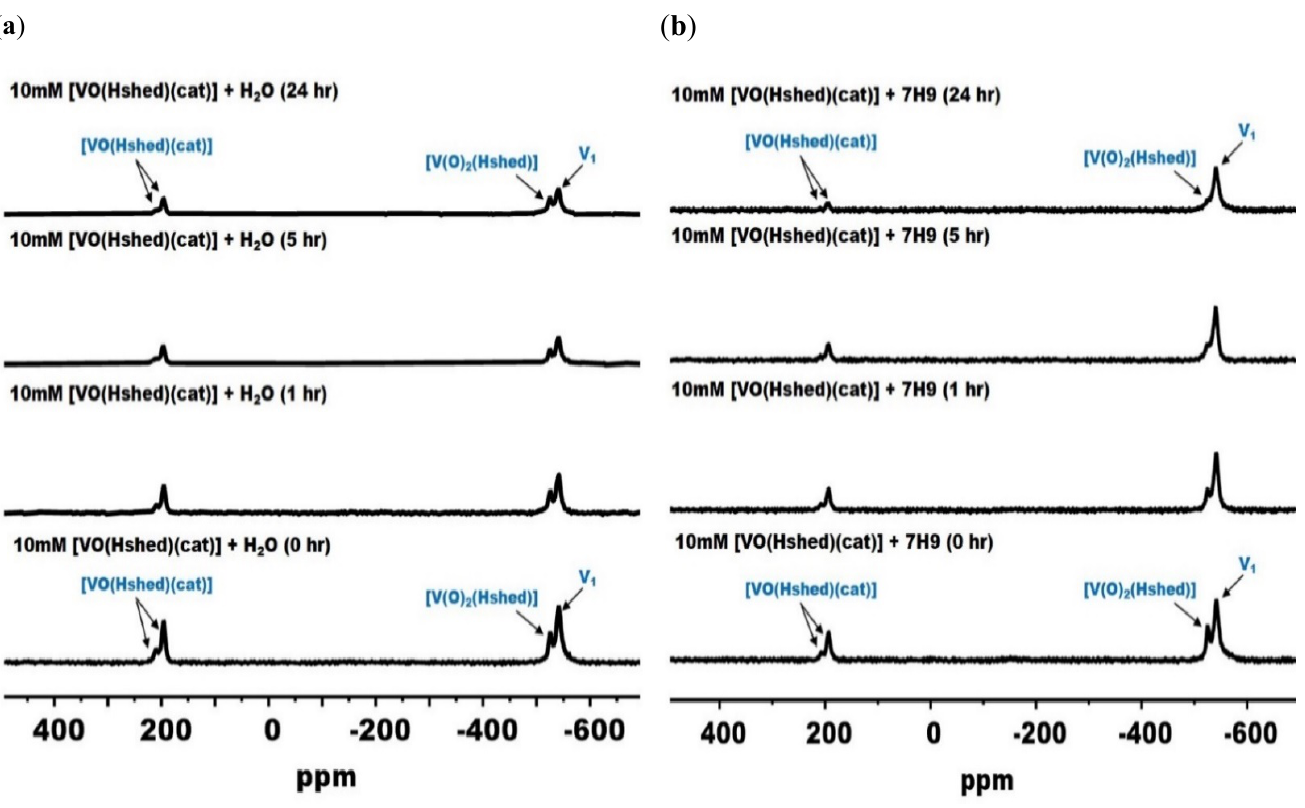
Figure 6. 51 V NMR spectra of 10 mM [VO(Hshed)(cat)] at 0, 1, 5, and 24 h time points in ( a ) 50:50 H 2 O:DMSO or in ( b ) 50:50 7H9 growth In Figure 7, NMR spectra are shown for the [VO(Hshed)] scaffold over a 24 h time period. These results indicate that the scaffold complex was unstable and immediately hydrolyzed to form V 1 within 1 h in both H 2 O:DMSO and 7H9:DMSO. Select studies were carried out with the [VO(Hshed)(3OMet)] complex and the [VO(Hshed)(CN)] complex. Both hydrolyzed rapidly with little intact complex left in the solution by the time the spectra were run. This information is summarized in Table 4. These data show higher stability than reported previously in pure aqueous solution or in media used to grow cancer cells [32–34].